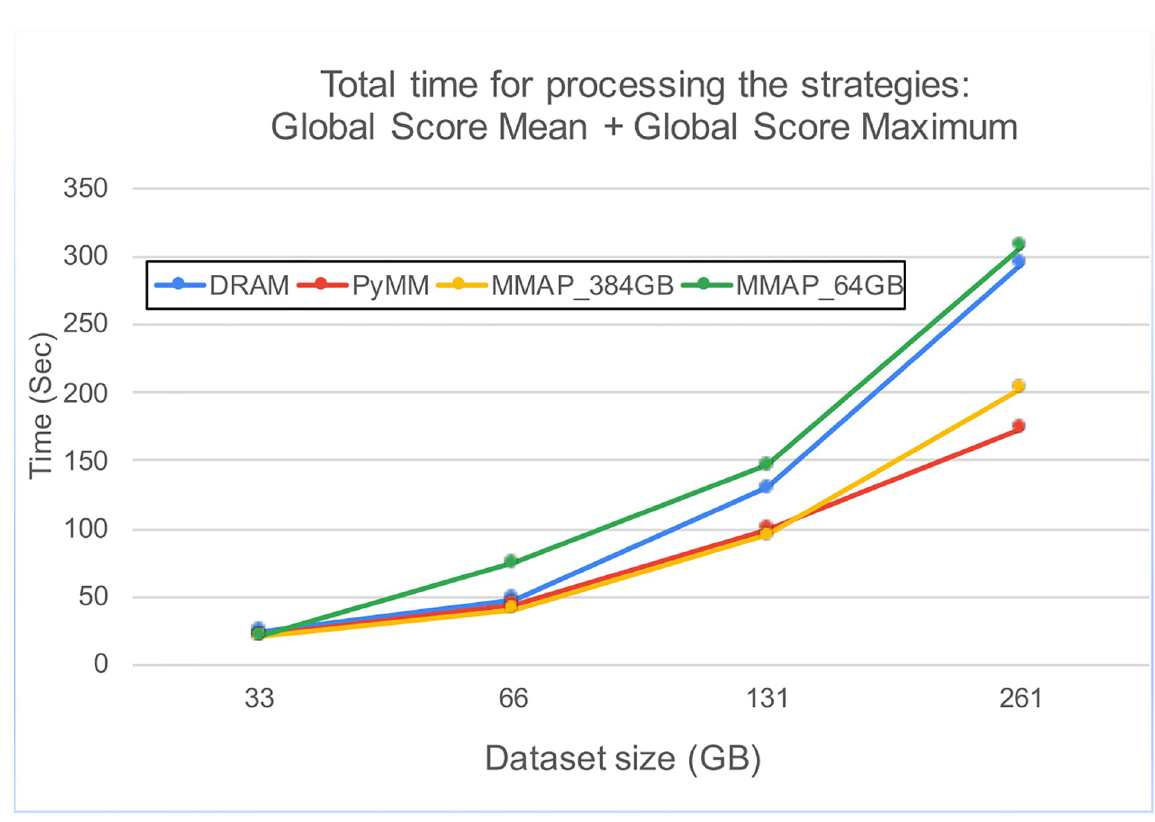
Fig 4. Strategy processing times. The total time for processing the two strategies: Global Score Mean and Global Score Maximum one after another.